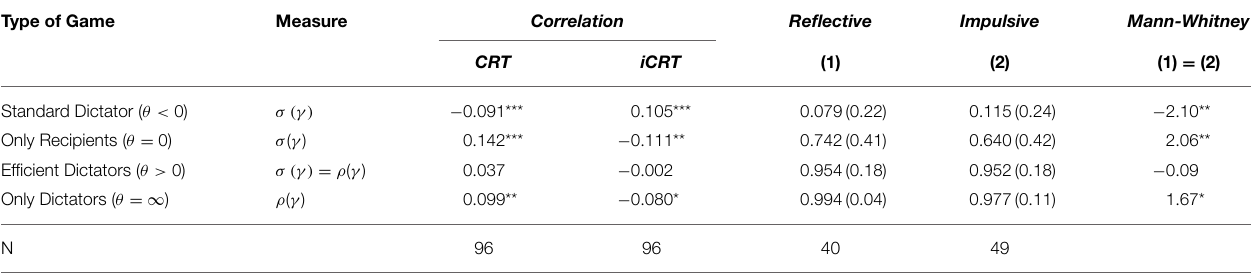
TABLE 2 | CRT and distributional concerns disaggregated for each Game type ( θ ). Type of Game